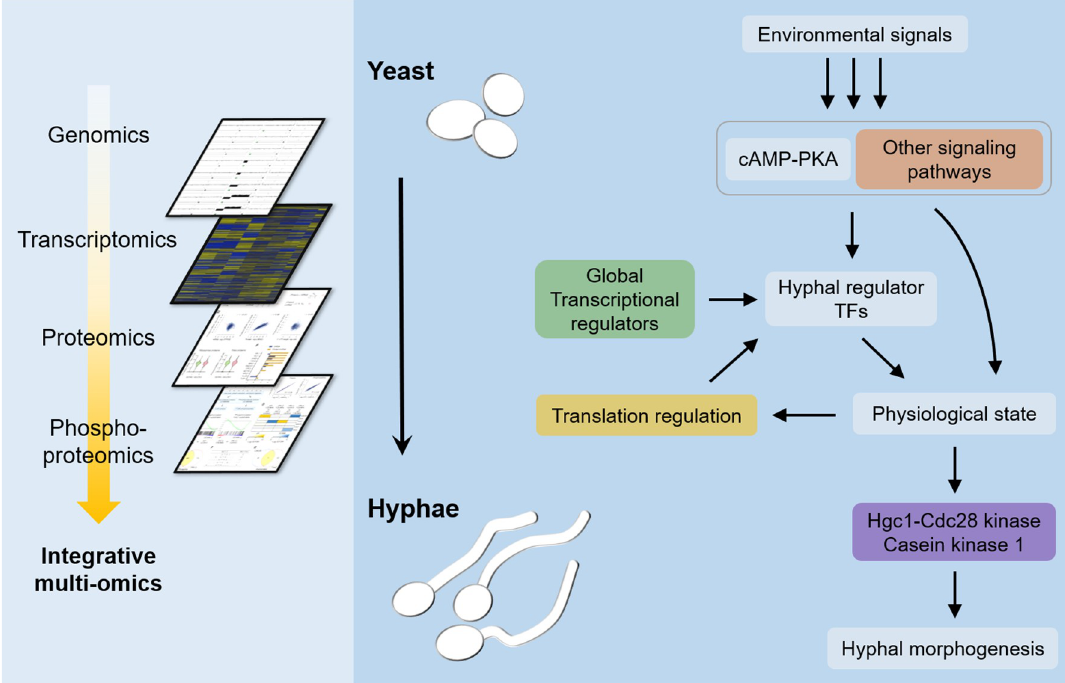
Fig 6. Integrative multi-omics profiling revealed new pathways that induce C . albicans hyphal formation in a cAMP- independent manner. New insights into the mechanisms of hyphal morphogenesis were obtained by performing integrative multi- omics profiling in C . albicans . Genetic changes in PR mutants were identified by performing genome analysis, gene-mapping by CRISPR-Cas9, and transcriptome analysis. These studies showed that gene dosage effects on BCY1 (negative regulator of PKA) and global transcription mechanisms promoted hyphal growth in the absence of cAMP. Integrating transcriptomic and proteomic data revealed that the translation rate of some hyphal regulatory TFs increased dramatically during hyphal induction while their mRNA levels did not, suggesting a special type of translational regulation promotes hyphal growth. Parallel comparisons of protein production and phosphorylation revealed that phosphorylation by Hgc1-Cdc28 kinase and yeast casein kinase 1 (Yck2) increased during hyphal induction, even in the absence of adenylyl cyclase, consistent with genetic studies indicating that these kinases play an important role in hyphal growth. Altogether, these data suggest a new model that various hyphal inducers and TFs are predicted to induce a new physiological state that promotes polarized filamentous growth, in part due to changes in protein phosphorylation.